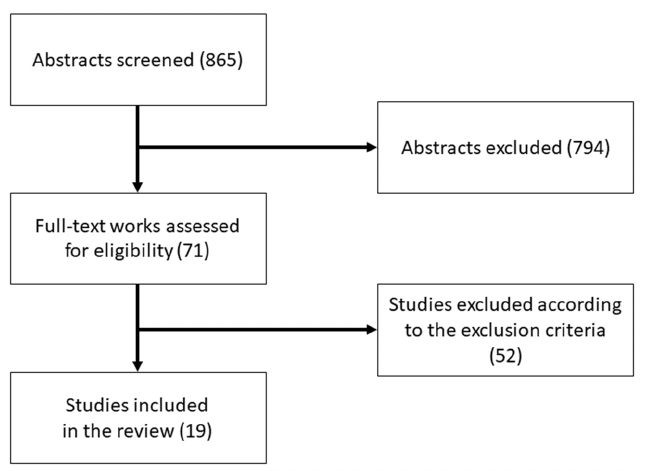
Figure 2. Diagram showing the information flow through the mini-review: the number of records identified, included, and excluded.